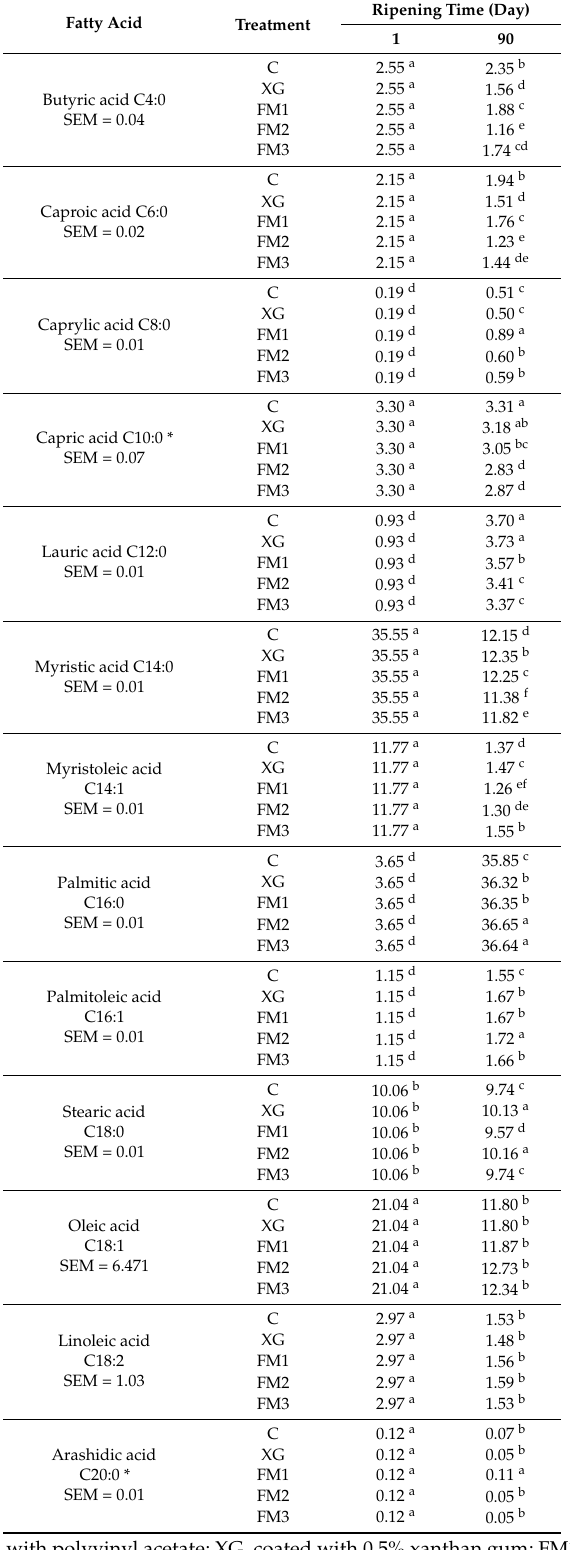
Table 2. Changes in free fatty acids (mg/100 g) during ripening of cheese trials. Ripening Time Fatty Acid Treatment